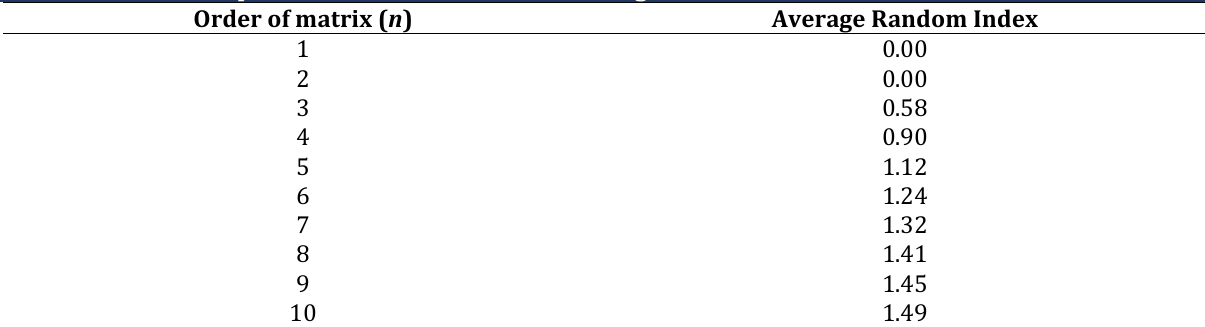
Table. 1: Relationship between Matrix Order and Average Random Index Order of matrix ( n ) Average Random Index 1